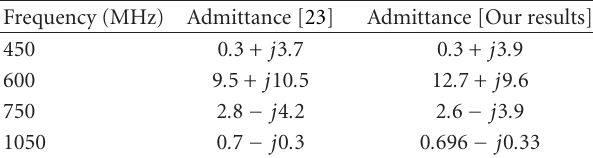
Table 1: Comparison of our results with literature data.